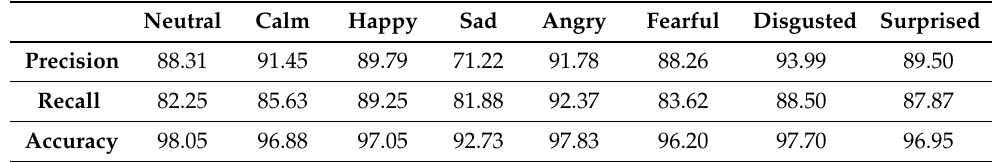
Figure 7. The top average accuracy of the 5-CV obtained for speech and visual modalities with a 95% confidence interval. In orange, the experiments of the top static models; in blue, the top models with sequential inputs; and in cyan, the top fusion model. Table 3. Precision, recall, and accuracy metrics per emotion for the top model that achieves an accuracy of 86.70%. All the metrics are calculated as an average of the 5-CV